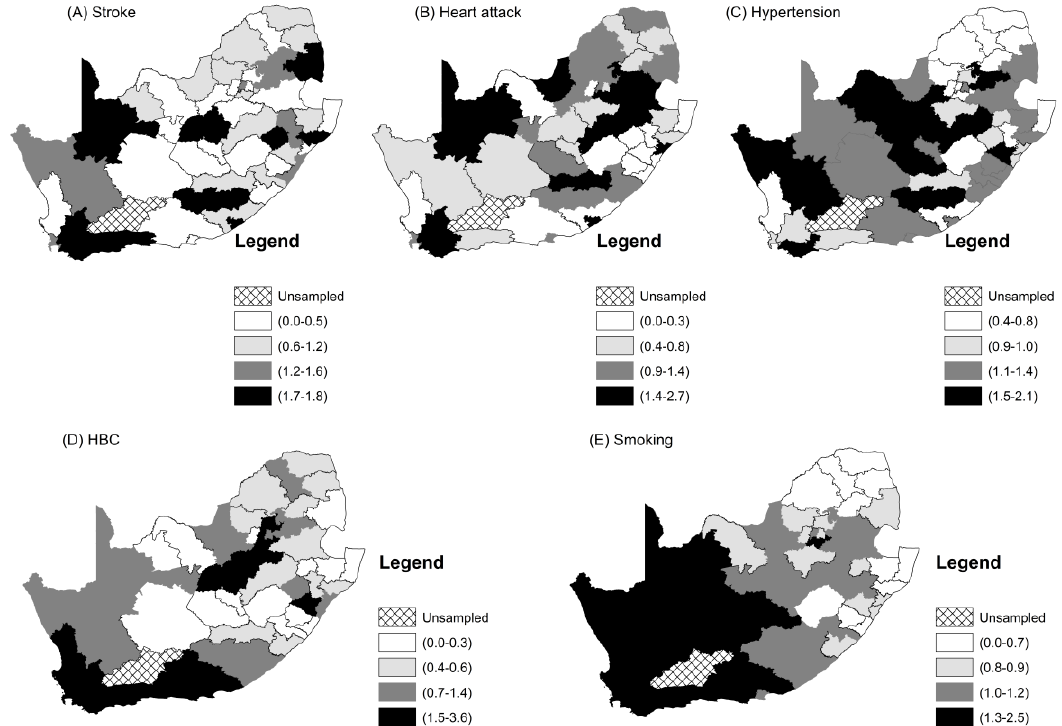
Figure 3. Maps of the district standardized incidence rates of the CVDs and their related risk factors.